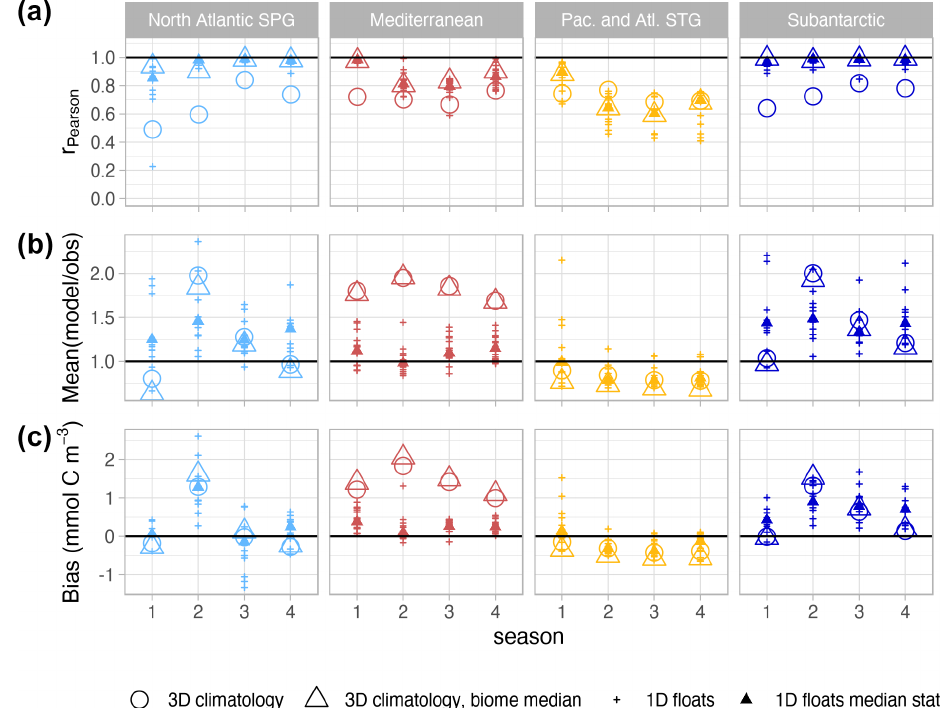
Figure 5. Summary of skill metrics for the comparison between PISCES and BGC-Argo particulate organic carbon (POC) profiles in different biomes and seasons. Pearson’s correlation coefficient, mean model / data quotient, and mean bias (mmolm − 3 ) are computed in linear space (untransformed data). Horizontal black lines show the benchmark values for each statistic. Symbols represent different types of simulations and data aggregation levels. In the case of the PISCES 3D climatological simulation, the statistics are computed at two spatial aggregation levels: using all the grid cells with matching BGC-Argo profiles in a given biome (circles), and after averaging all the documented grid cells within the biome (empty triangles), as displayed in Fig. 4. In the case of the PISCES 1D simulations, statistics are computed for each individual CATS separately (small crosses), and the biome-season median is also shown (small filled